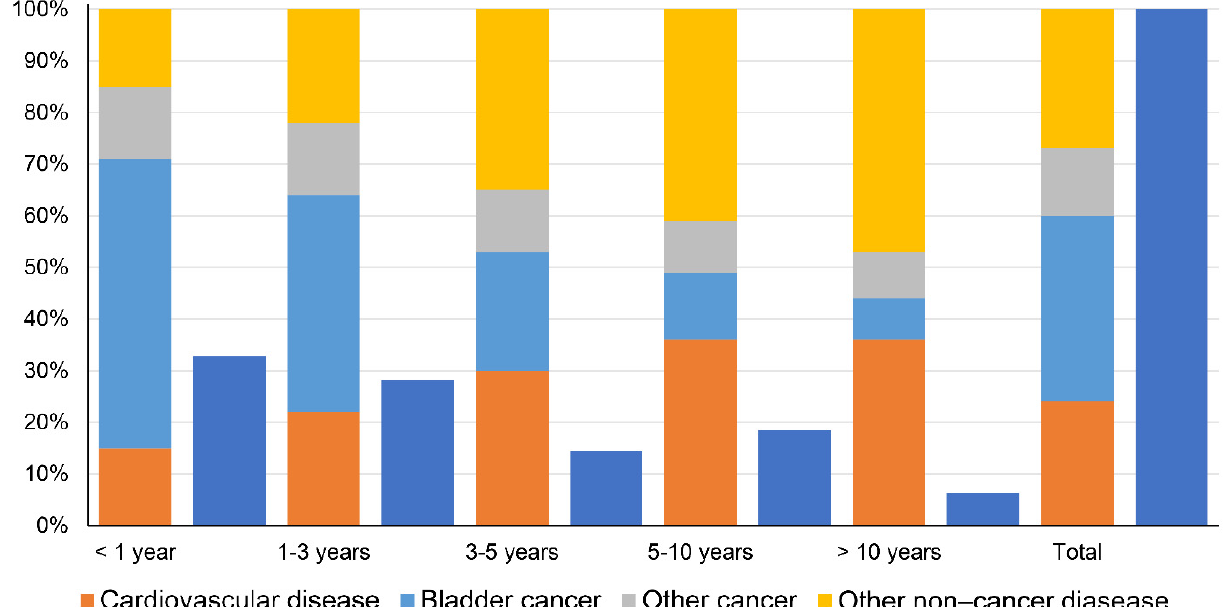
Figure 2. Causes of death in each latency period following bladder cancer diagnosis (dark blue indicates the percentage of the total number of deaths for each latency period). Table 1. Baseline features and standardized mortality ratios of cardiovascular mortality in patients with bladder